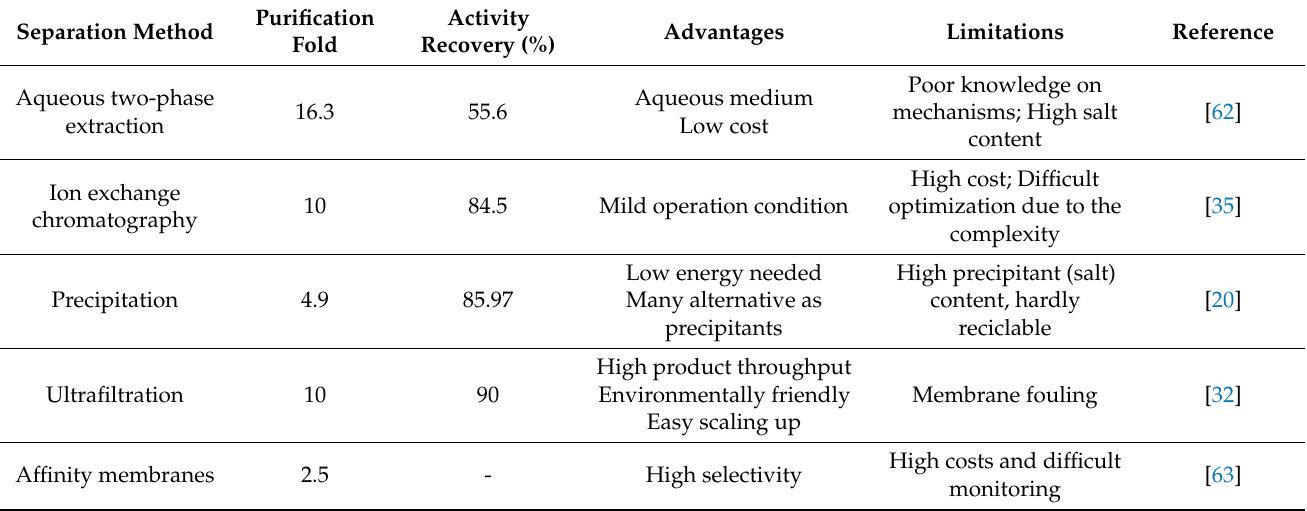
Table 3. Comparison of the different bromelain separation